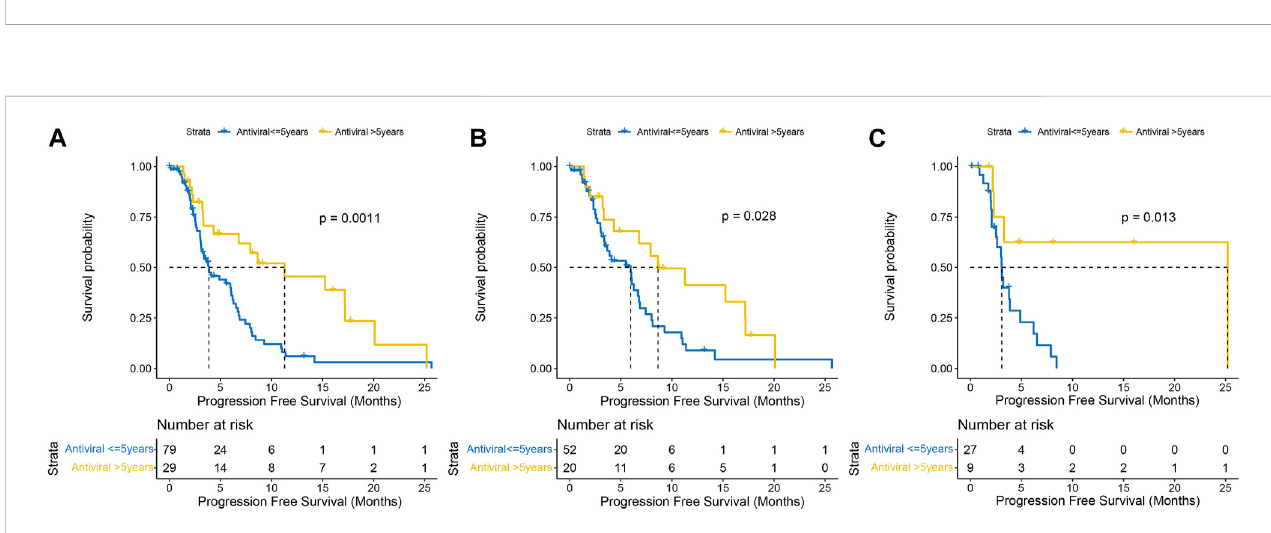
FIGURE 2 Kaplan-Meier curves of overall survival (A) and progression-free survival (B) between HBV-HCC and HCV-HCC.